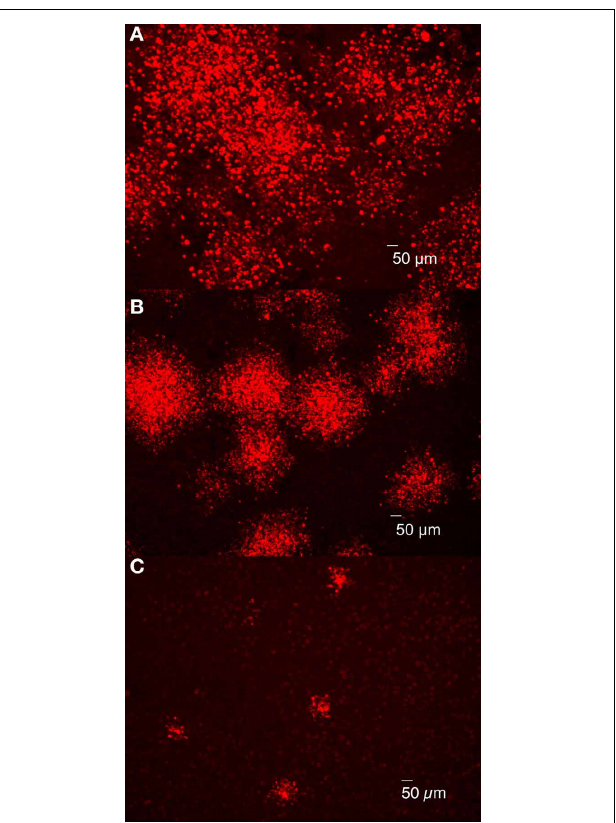
FIGURE 3 | Brucella cytotoxicity was essential for bacterial egress and subsequent re-infection. J774.A1 macrophages were infected with 16M (cid:2) manBA (A) , RB51 (B) or 16M (cid:2) manBA (cid:2) virB 2 (C) at an MOI of 0.1. Agarose overlay and DMEM were added at 1h p.i. and incubated for 4 days. Following formaldehyde fixation, the cells were stained via IFA to detect rough Brucella observed using IX70 microscopy. Scale bar, 50 μ m.